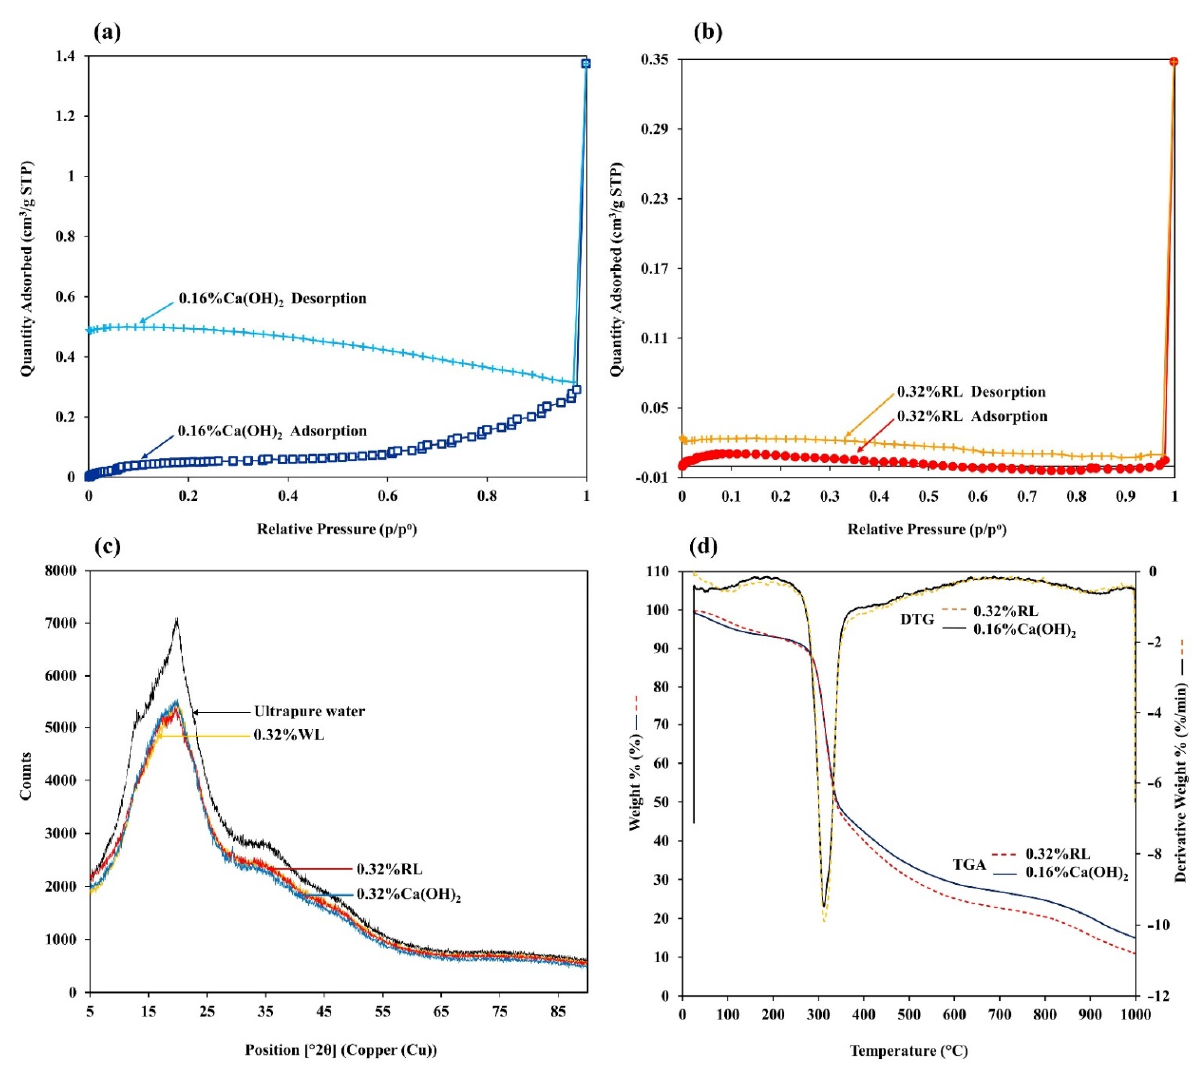
Figure 5. Nitrogen adsorption-desorption isotherms of the cryogels prepared from ( a ) 0.16% Ca(OH) 2 , and ( b ) 0.32% RL; ( c ) XRD and, ( d ) TGA patterns of the synthesized cryogels.